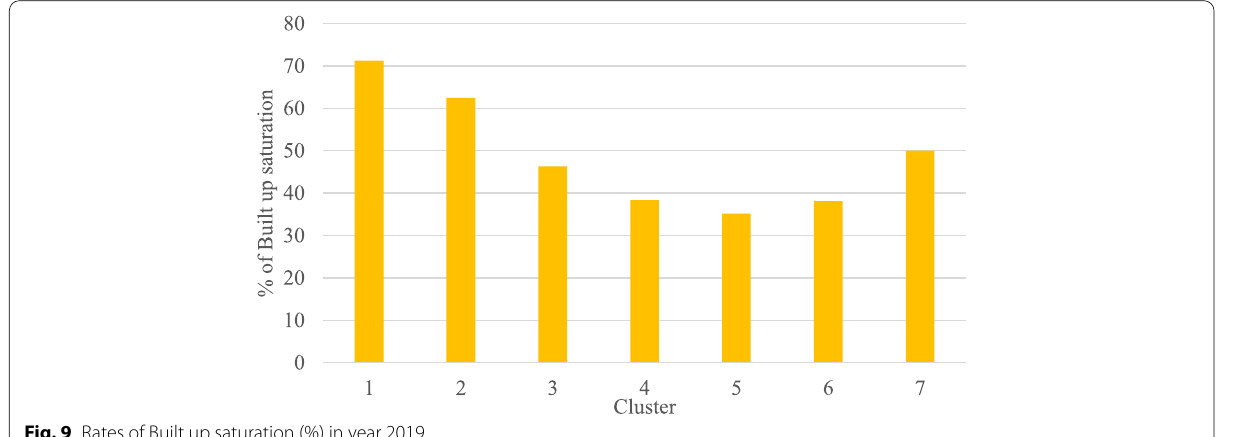
Fig. 9 Rates of Built up saturation (%) in year 2019